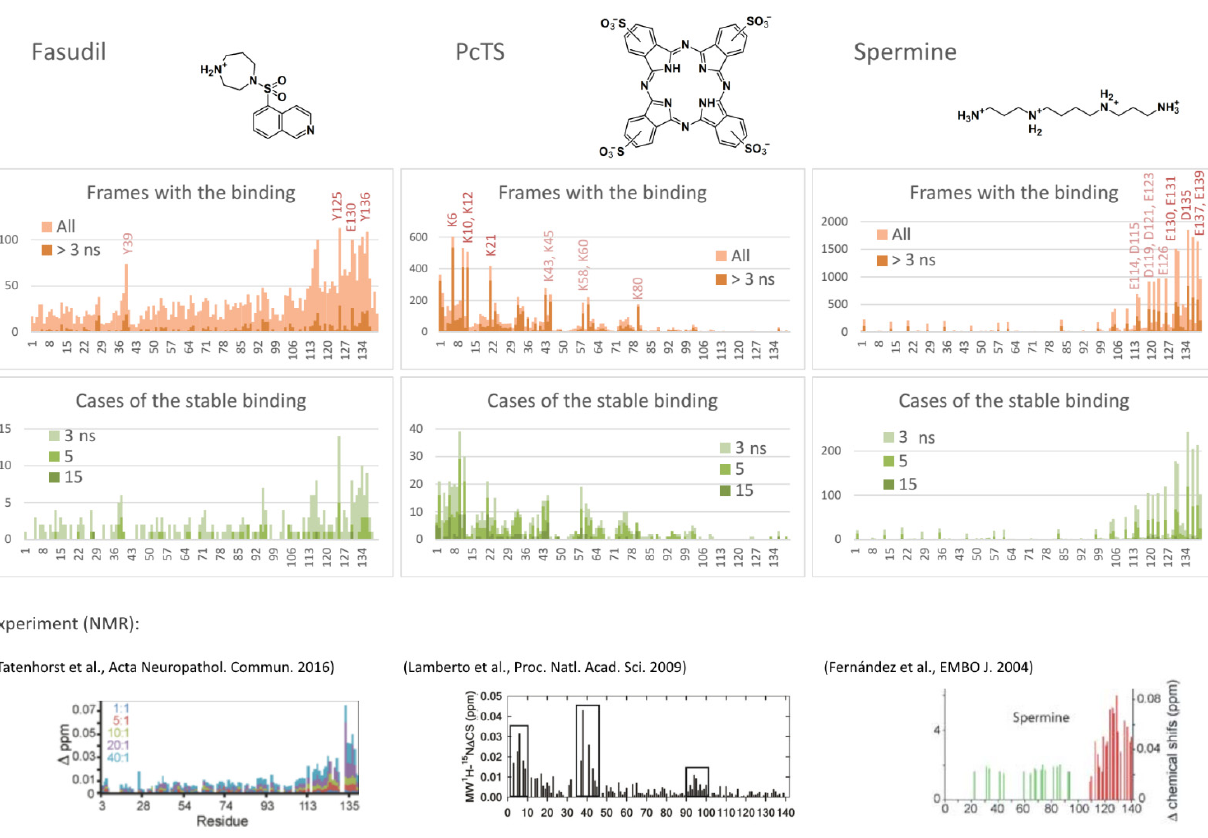
Figure 1. Binding profiles of fasudil ( left ), PcTS ( center ), and spermine ( right ); number of all or stable frames with binding to a particular residue, number of cases of continuous binding for at least 3, 5, or 15 ns, and experimental data of changes in the mean weighted chemical shifts reprinted with permission from [11–13].